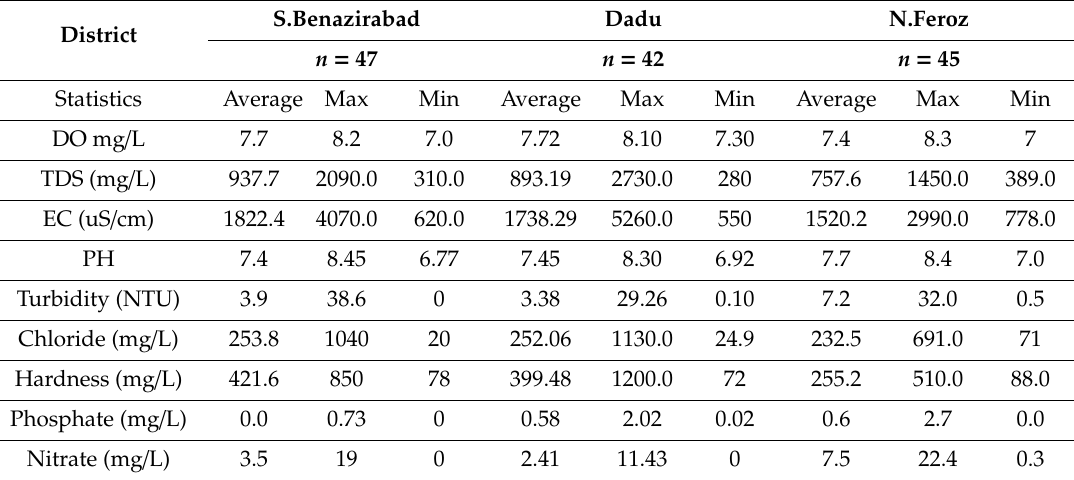
Table 6. Water quality parameters of Central